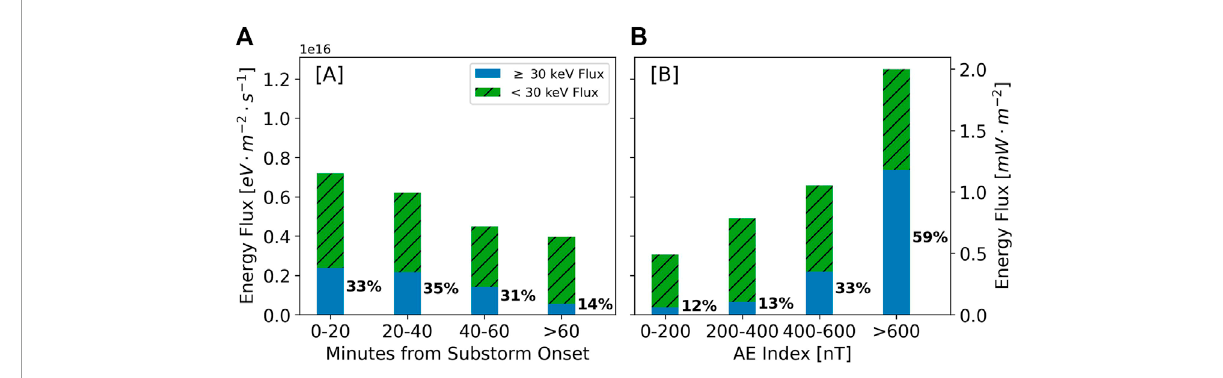
FIGURE 4 The high ( ≥ 30 keV) and low ( < 30 keV) differential energy flux contributions to pulsating aurora events occurring in four temporal bins relative to substorm onset (A) and AE index (B) .